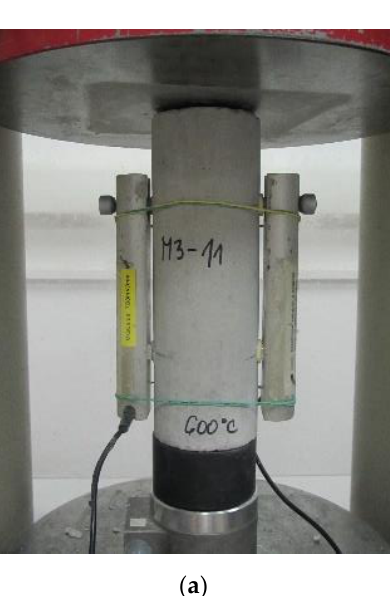
Figure 4. Experimental setup — test machine and electronic equipment for compressive stress – strain monitoring.